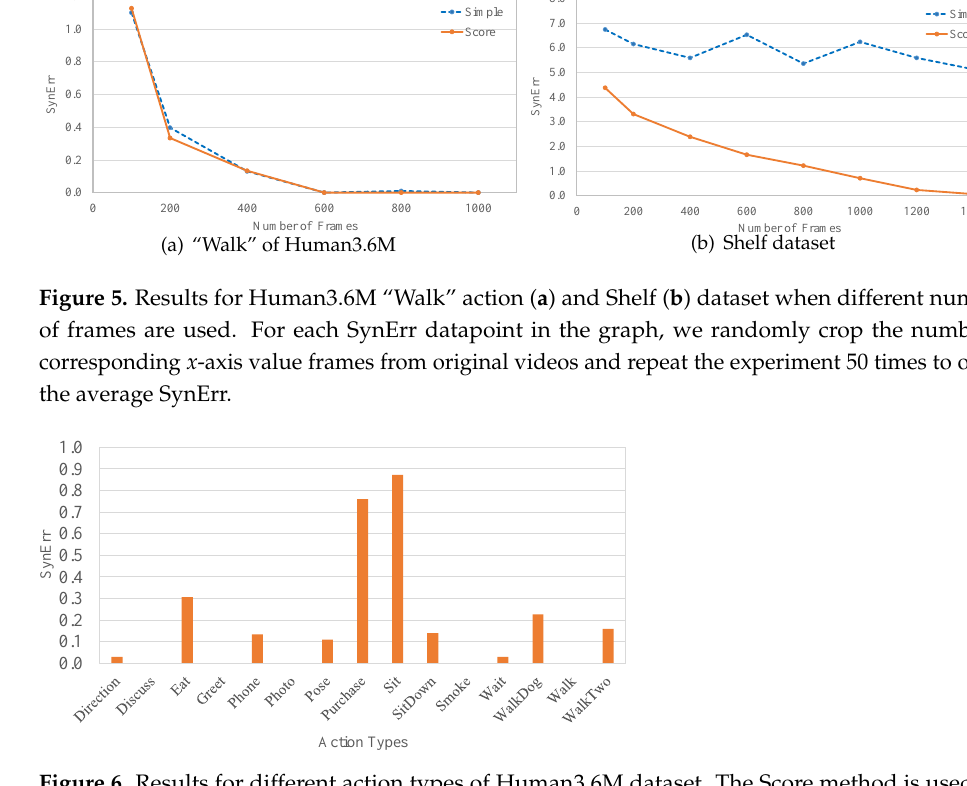
Figure 6. Results for different action types of Human3.6M dataset. The Score method is used. We randomly crop 600 frames from original videos and repeat the experiment for 50 times to obtain the average